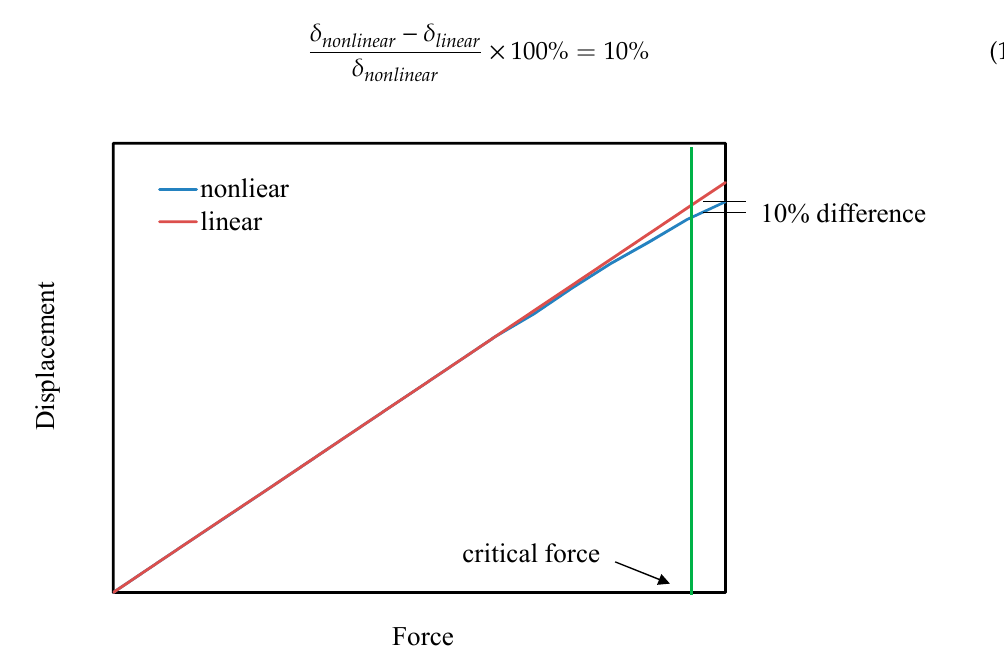
Figure 6. Definition of critical force for the ASSM.